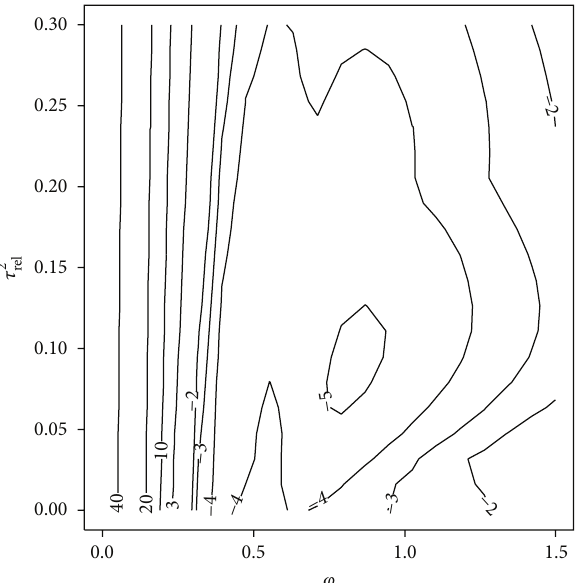
Figure 3: Two-dimensional likelihood profile for (𝜑,𝜏 2 ) for the GLSM.